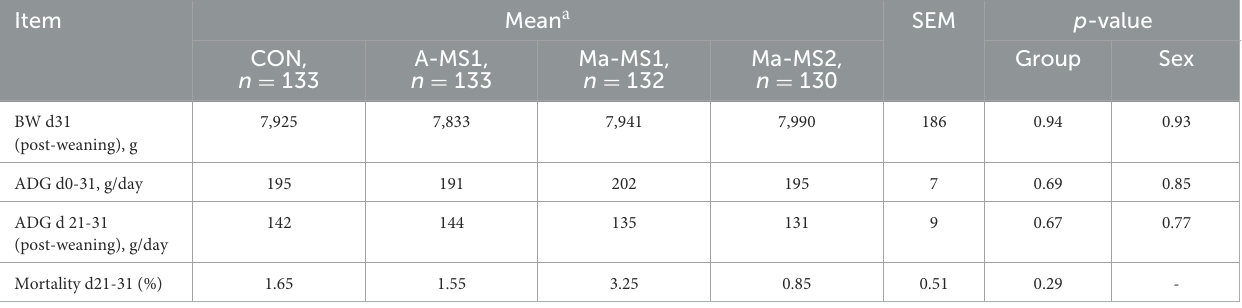
TABLE 6 Effect of milk supplementation on piglets’ performance 10 days